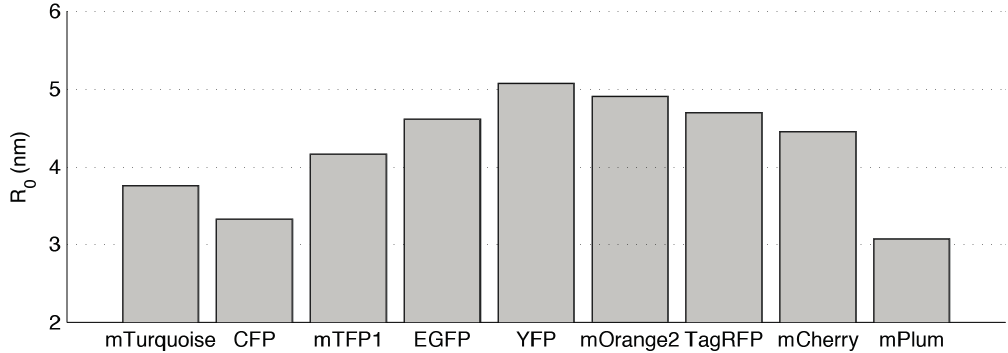
Figure 1. Homo-FRET Förster distance for a number of common fluorophores Plot of the Förster distance R 0 for homo-FRET between common fluorescent proteins calculated as described in the supplementary